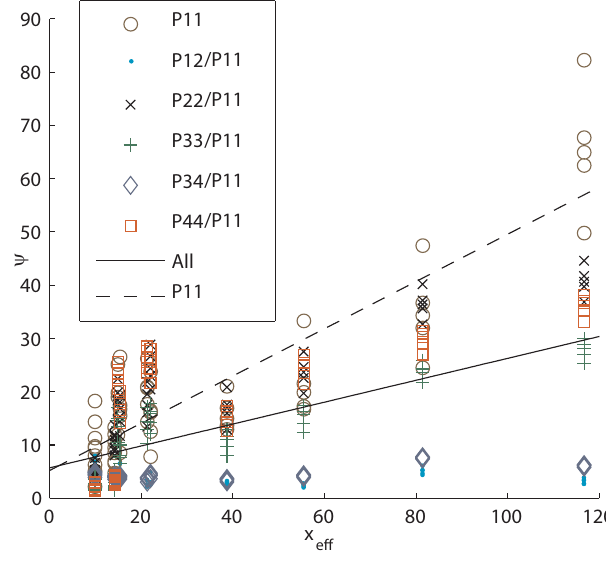
Fig. 3. Minimum ψ , Eq. (10), errors of the scattering-matrix ele- ments as a function of the effective size parameter x eff . All modeled refractive indices are included. The solid line (slope = 0.2) is linear regression representing the average of all dots while the dashed line (slope = 0.4) is solely for P 11